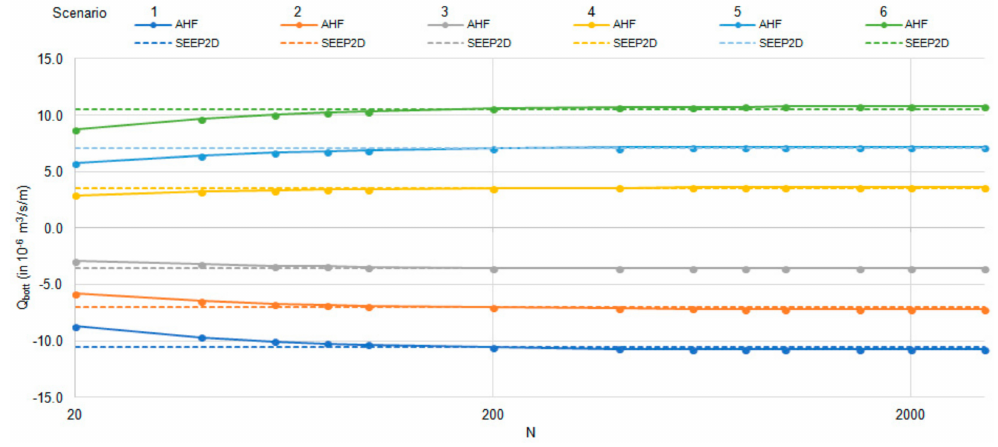
( N ) for six scenarios ( Φ * – H r bott